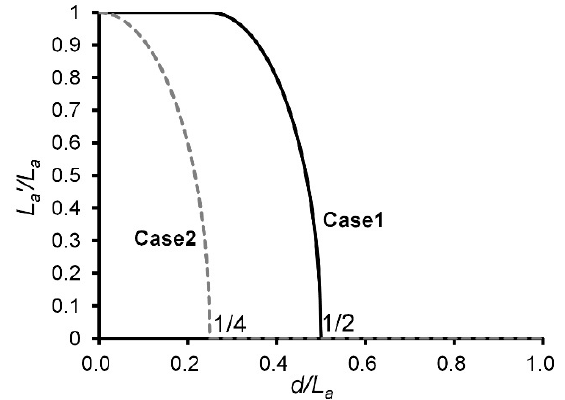
Figure 4. Relations between d and L in Cases 1 and 2.